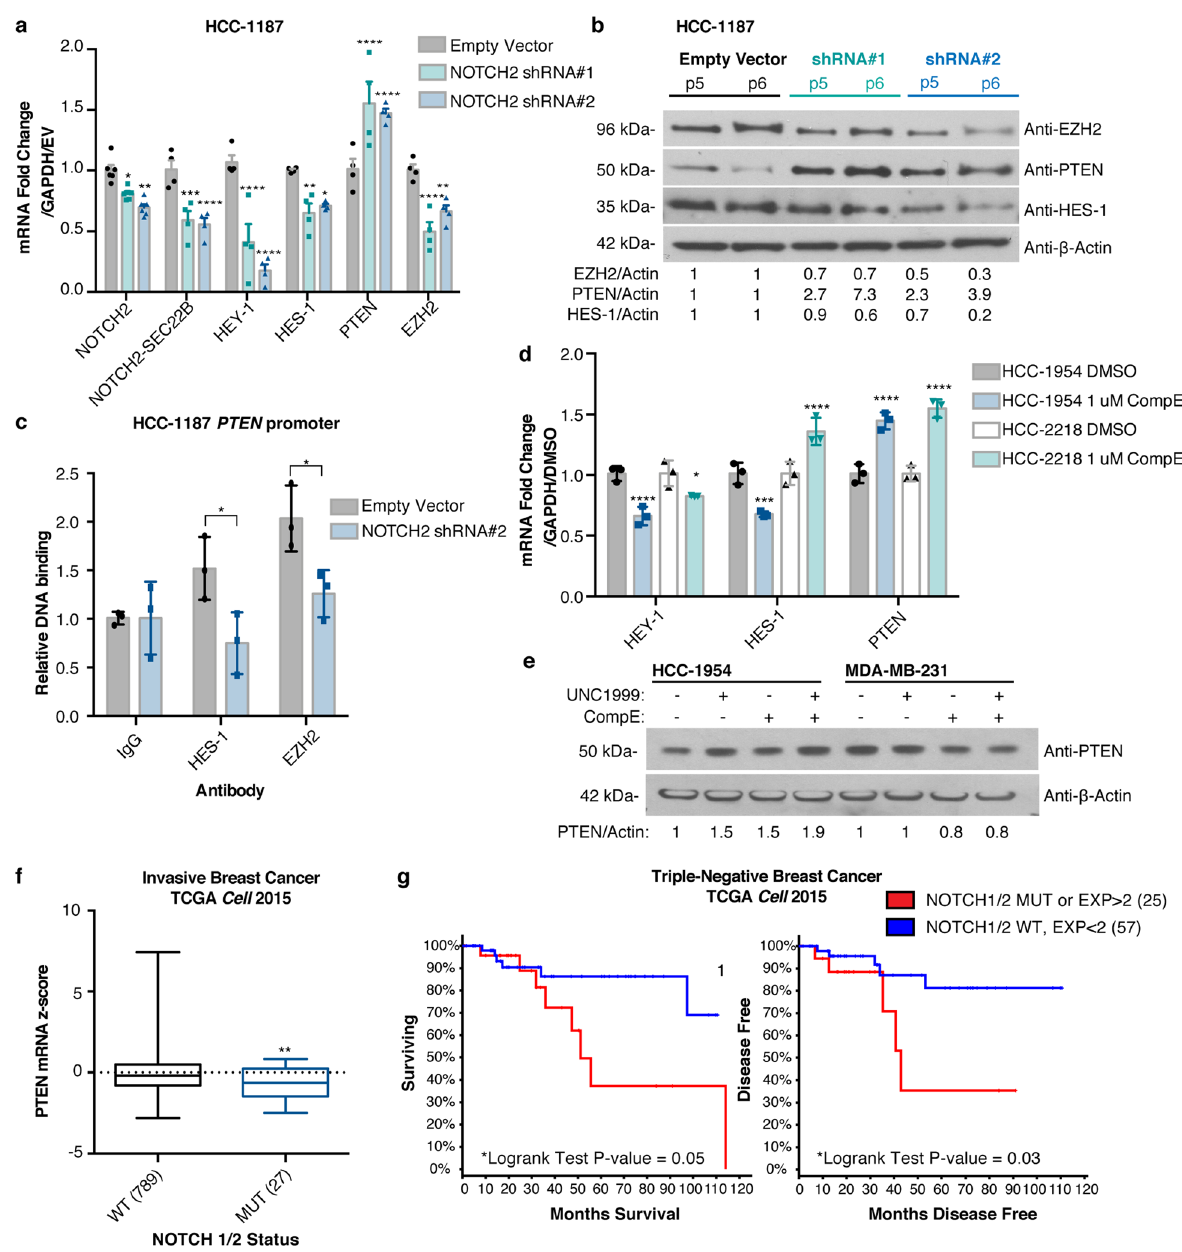
Fig. 5 Mutant NOTCH1/2 collaborates with EZH2 to drive transcriptional repression of PTEN and associates with poor prognosis. a Transcript levels measured by qRT-PCR and ( b ) protein levels measured by immunoblotting of indicated genes following stable knockdown of NOTCH2. P5, P6 indicate passage number after infection. β -actin was the loading control and quanti fi cation is shown. Error bars: mean ± s.e.m., n = 4 experiments. Signi fi cance from Ctrl: two-way ANOVA, Dunnett ’ s correction. c ChIP-qPCR binding of indicated proteins to the PTEN promoter (Site B 23 , between Sites 3 and 4, Fig. 2a) following stable knockdown of NOTCH2. Relative DNA Binding is % input (normalized to IgG). Signi fi cance from Ctrl: two-way ANOVA, Sidak ’ s correction. Error bars: mean ± s.d., triplicate measurements. d HCC-1954 and HCC-2218 cells were treated for 6 days with 1 μ M Compound E and expression of indicated genes were measured using qRT-PCR. Error bars: mean ± s.d., triplicate measurements. Signi fi cance from Ctrl: 2-way ANOVA, Tukey ’ s correction. e HCC-1954 and MDA-MB-231 cells were treated for 6 days with 1 μ M Compound E and/or UNC1999 and expression of indicated genes were measured using immunoblotting. β -actin was the loading control and quanti fi cation is shown. f Boxplots of PTEN RNA-seq data from invasive breast cancer cases 34 in NOTCH1/2 wild-type (WT) or mutant (MUT) groups. Number of cases indicated for each group (total n = 816). Signi fi cance: Mann – Whitney test. g Reduced overall survival and disease-free survival in TNBC cases 34 harboring NOTCH1 or NOTCH2 mutations or overexpression (RNA-seq z -score > 2). Number of cases indicated for each group (total n = 82). Signi fi cance: Logrank test. (**** P < 0.0001; *** P < 0.001; ** P < 0.01; * P <